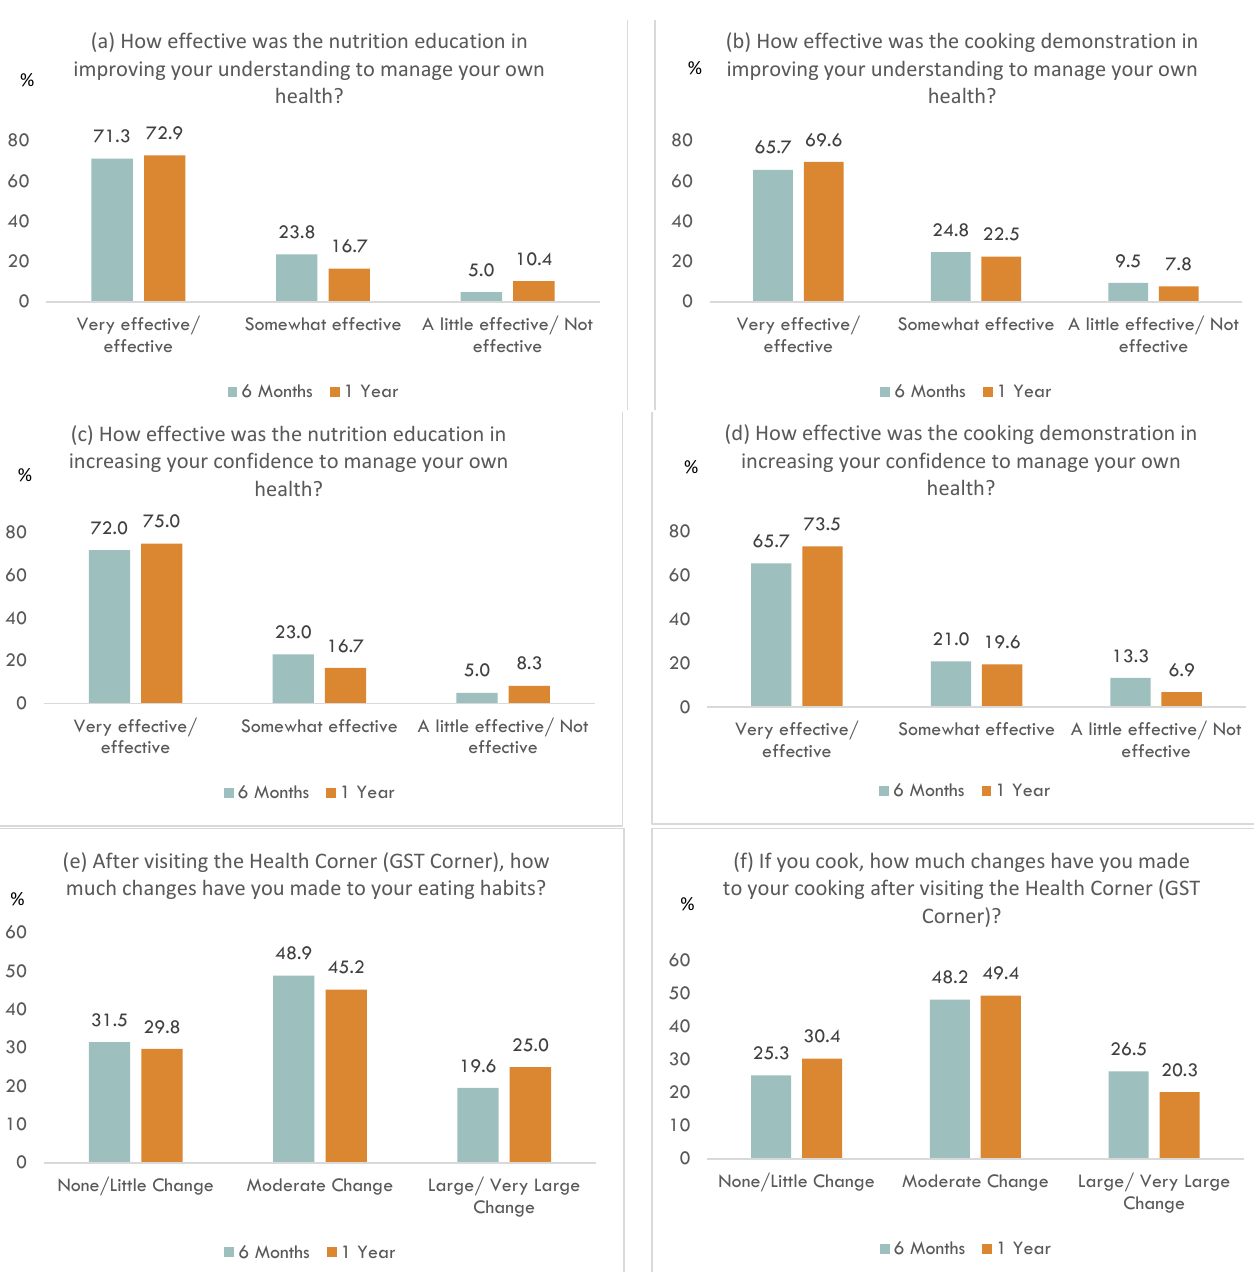
tion education in improving understanding to manage own health, ( b ) Effectiveness of the cooking